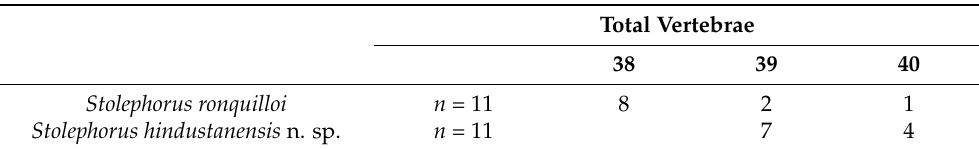
Table 3. Frequency distribution of total vertebral numbers in Stolephorus ronquilloi and Stolephorus hindustanensis n. sp. Total Vertebrae 38 39 40 Stolephorus ronquilloi n = 11 8 2 1 Stolephorus hindustanensis n. sp. n = 11 7